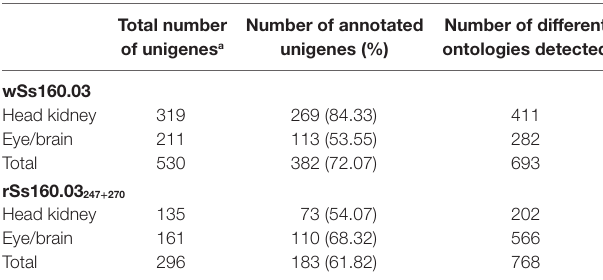
Table 3 | Annotated unigenes in gene ontology database.